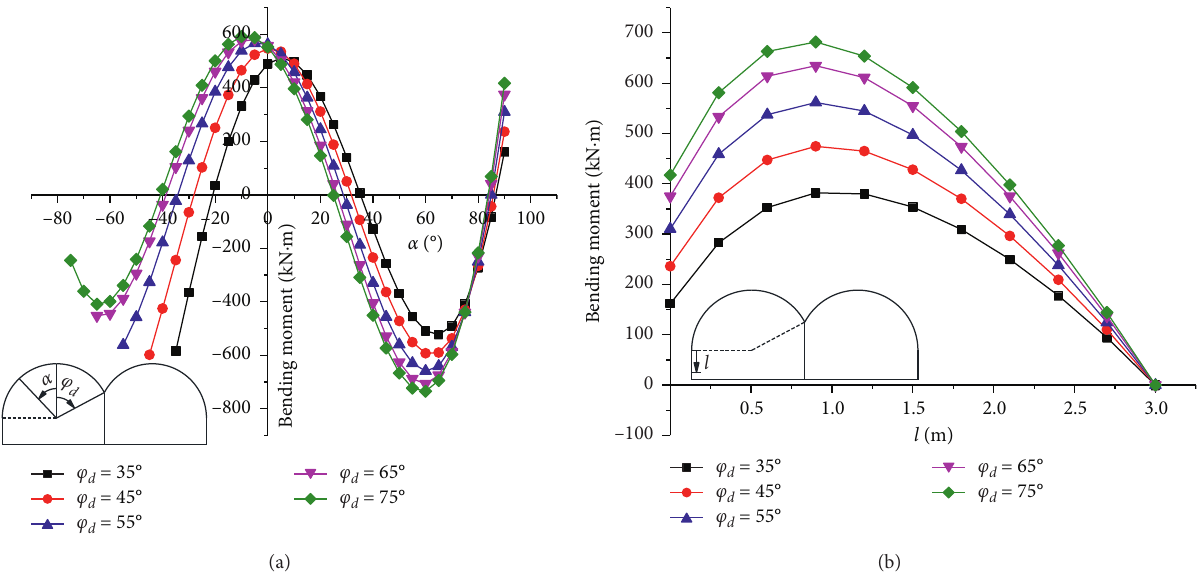
Figure 18: Variations of bending moment with φ